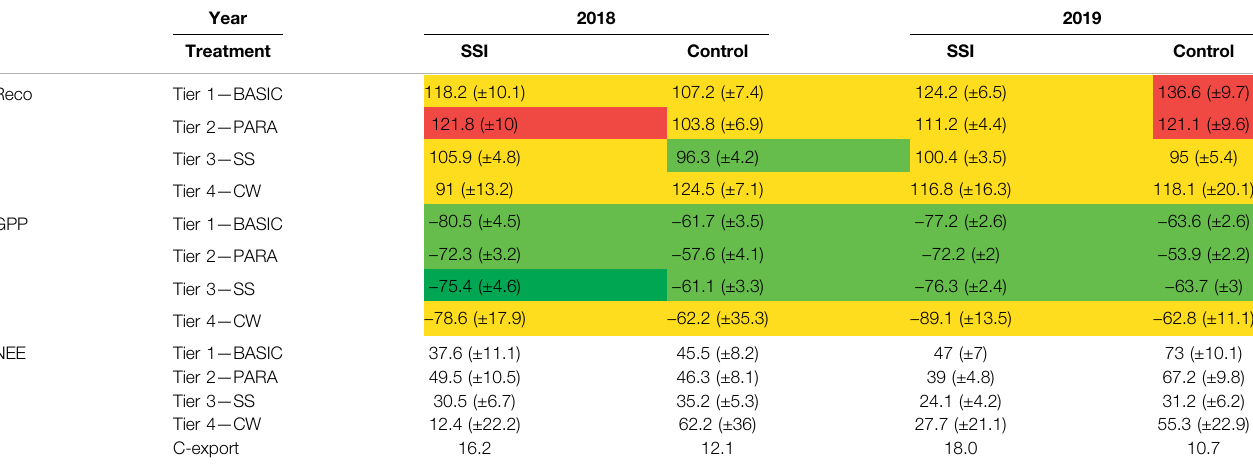
TABLE3| AnnualCO 2 budgetsofthe fi fthfarmlocationasademonstrationoftheframeworkapplicability.DataareCO 2 budgetestimatesint ha − 1 yr − 1 (±SD).C-exportwas translated from grass yield in t CO 2 -eq ha − 1 yr − 1